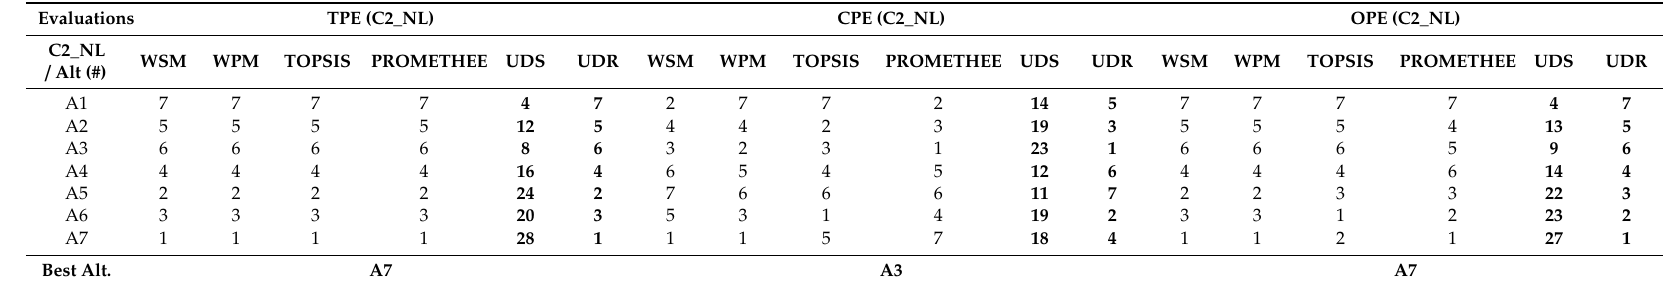
Table 8. Order of the ranks across TPE, CPE, and OPE in C2_NL for 33-bus